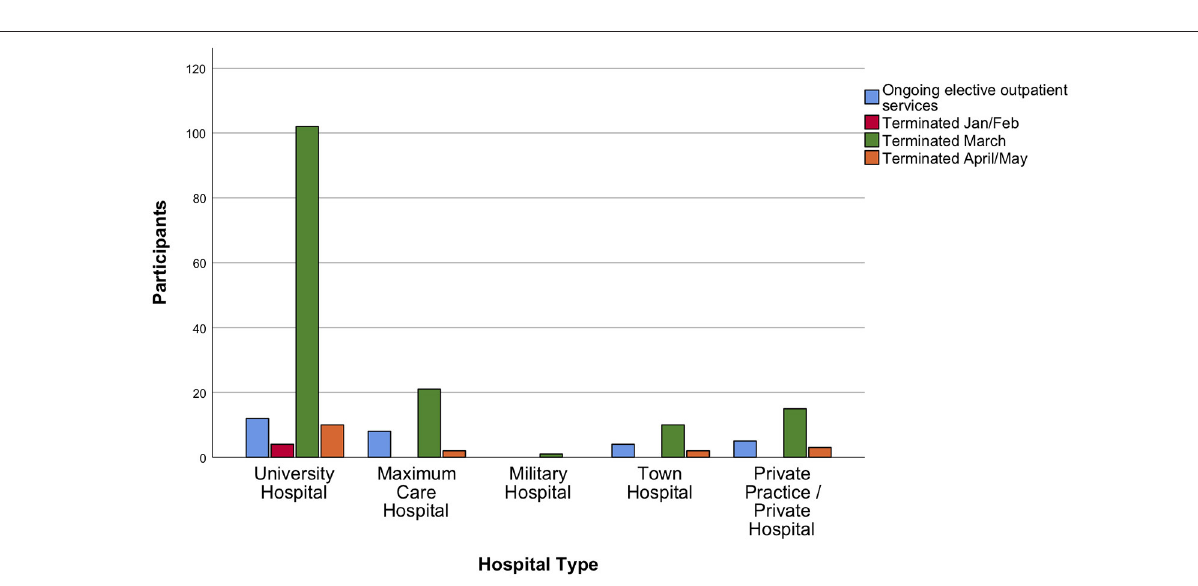
In relation to the pre-COVID-19 practice, the total volume of neurosurgical activities was on average reduced by 68 ± 21.8%. Cranial surgery decreased by 54 ± 31.3%, spine surgery by 71 ± 31%, and emergency surgery by 35 ± 31.9%. Decline in average weekly surgery numbers is shown in Figures 5 , 6